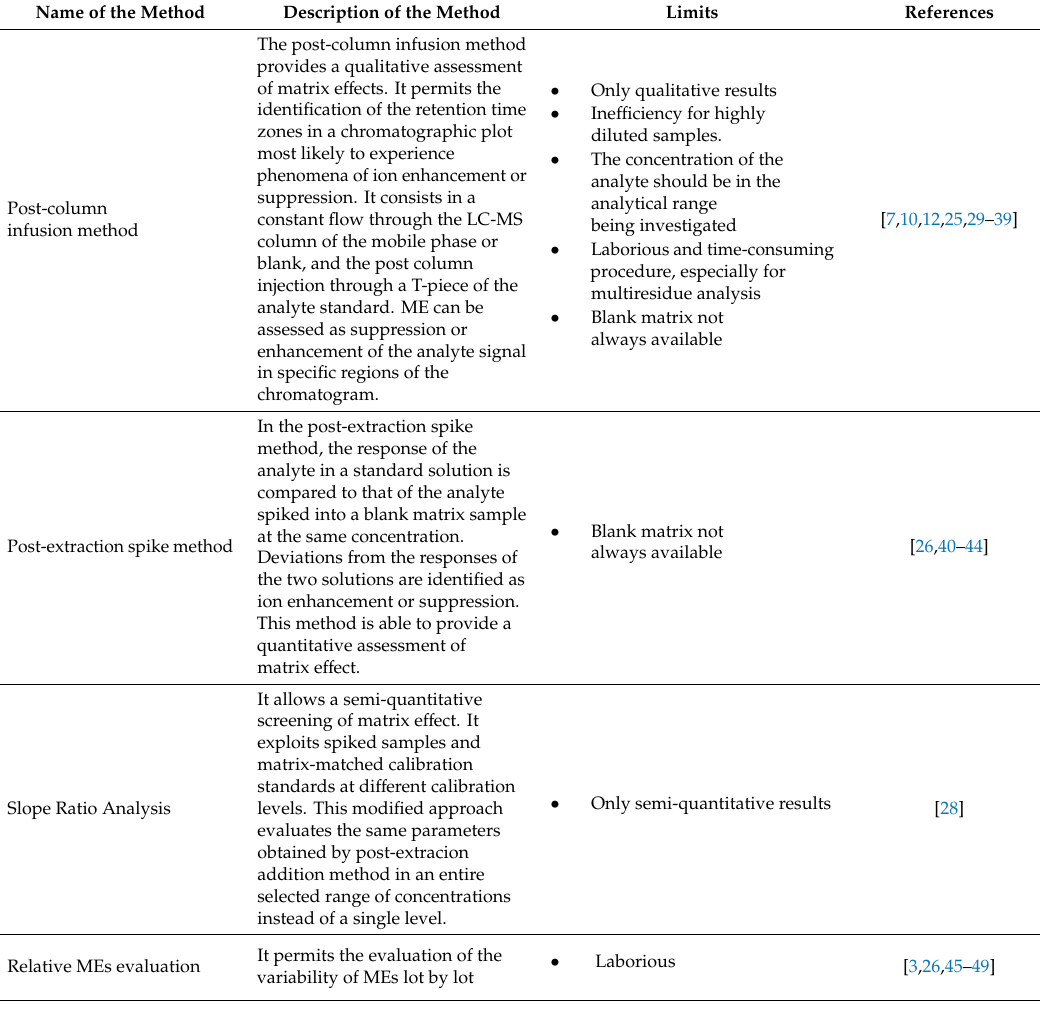
Table 1. Methods for the evaluation of matrix e ff ects.